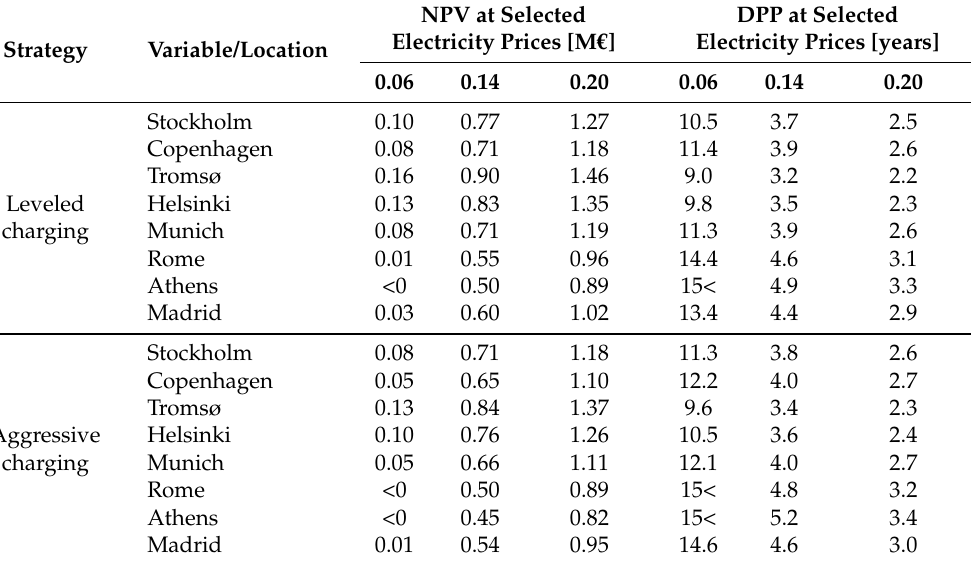
Table 7. Net present value (NPV) and discounted payback period (DPP) for selected cities with the PC design at different electricity prices when applying the leveled and aggressive charging strategy.